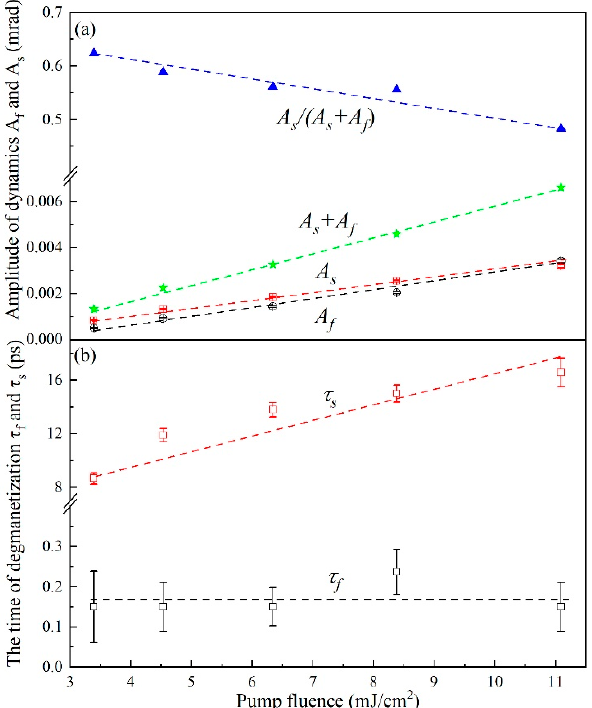
Figure 4. ( a ) The amplitudes of fast demagnetization (open circles, A f ) and slow demagnetization (open squares, A s ) versus the pump fluence. ( b ) The relaxation time 𝜏 f and 𝜏 s for laser-induced demagnetization are given as a function of the pump fluence. The dashed lines are the guiding eye.